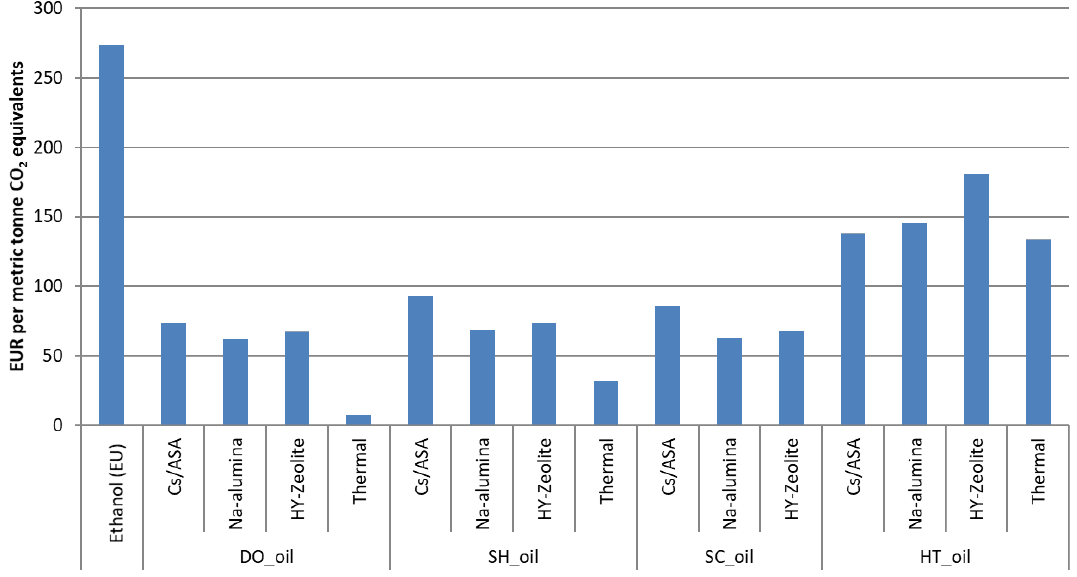
Figure 8. Comparison of the CO 2 abatement costs of pyrolysis biofuel from four cases and four scenarios and ethanol with gasoline as a reference.